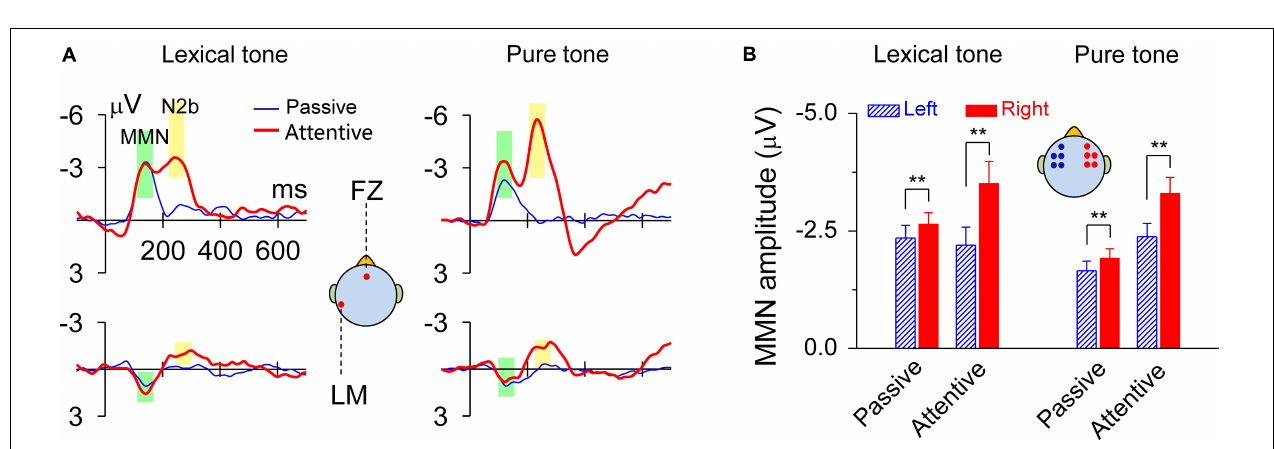
FIGURE 1 | Dichotic listening oddball paradigm. In the lexical tone experiment, the standard stimulus was a sound (bai1) (syllable/bai/with a flat tone) to both ears (diotic sounds). Occasionally, the sound/bai1/to one of the ears was replaced by /bai2/, or /bai3/, or /bai4/ (syllable/bai/ with a rising, or a dipping, or a falling tone) as the deviant stimulus (dichotic sounds). In the pure tone experiment, the standard stimulus was a 550 Hz pure tone and the deviant stimulus was a 750 or 350 Hz pure tone. Mismatch negativity response (MMN) and reaction time during dichotic listening judgment were simultaneously recorded.